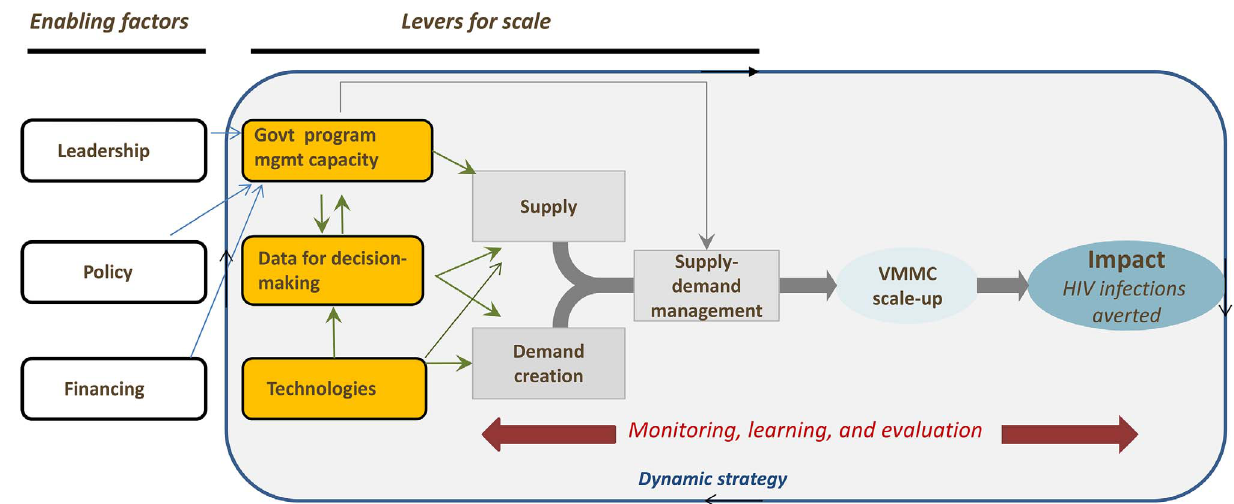
Figure 5. Enabling factors and levers to achieve scale and impact for the voluntary medical male circumcision program. Strong enabling factors of leadership, policy, and financing are needed to accelerate and maximize the impact of scale-up of the VMMC program. The levers for scale—government management capacity, use of data for decision-making, and technologies—are needed to match supply and demand.